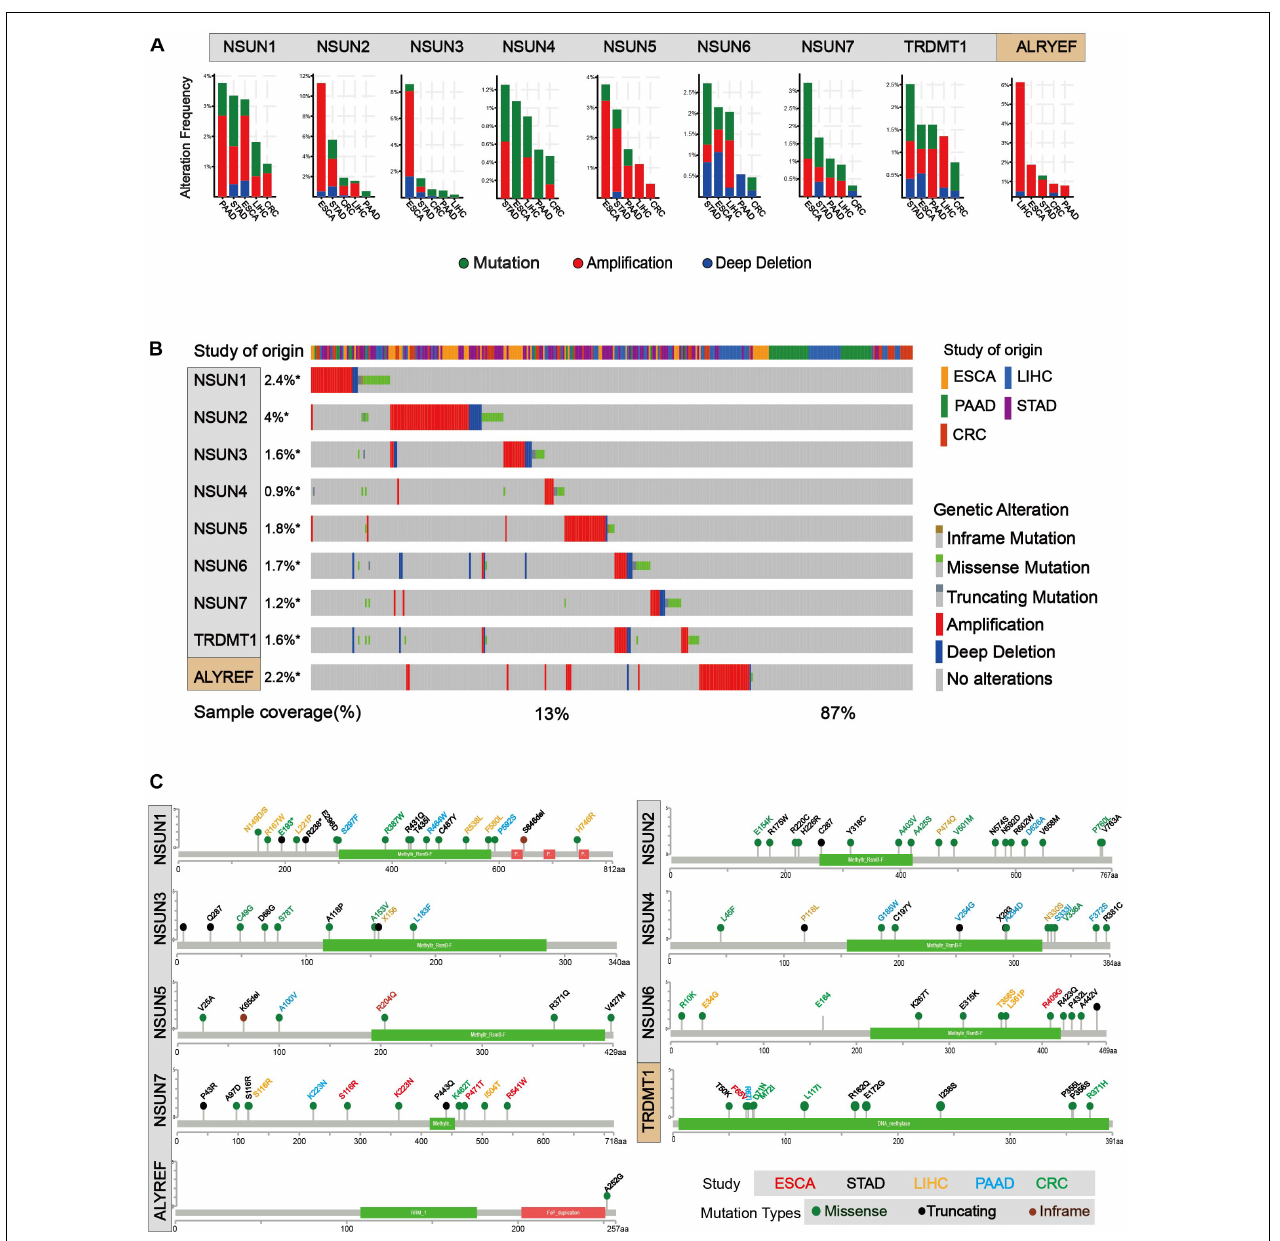
FIGURE 3 | Mutations of m 5 C writer and reader in GI cancer. (A) Alteration frequency of m 5 C regulatory factors in GI cancer, including mutations, amplification, and deletion, and multiple changes were analyzed from the TCGA database and studied in cBioPortal. About 28% (52/186) of esophageal cancer, 8% (14/186) of pancreatic cancer, 19% (91/478) of stomach cancer, 5% (33/640) of colorectal cancer, 13% (56/442) of liver cancer, and 12% (234/1,928) of GI cancer had genomic changes of m 5 C regulators. (B) The alteration frequency of m 5 C regulatory factors in gastrointestinal cancer from the TCGA database was analyzed in cBioPortal. The gene alteration frequencies of m 5 C regulators in GI cancer was 2.4% in NSUN1 , 4% in NSUN2 , 1.8% in NSUN5 , and 2.2% in ALYREF , etc. (C) Protein structure alteration (missense, truncating, and inframe mutation) was analyzed in GI